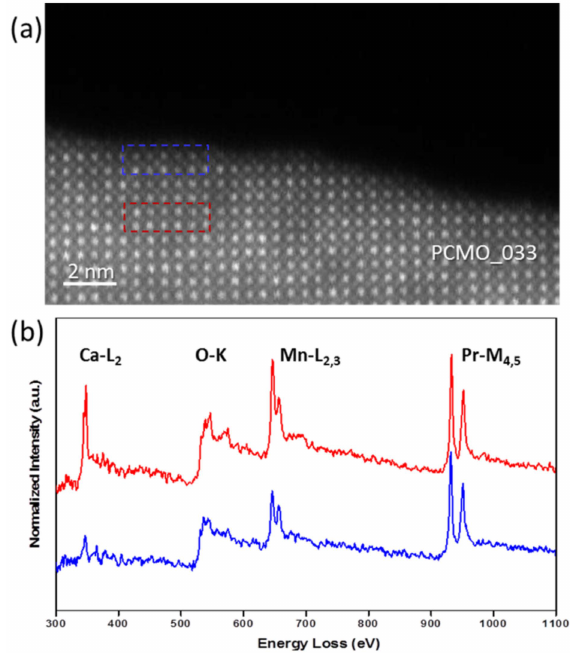
Figure 5. ( a ) HRSTEM image of PCMO (x = 0.33) with two selected area used to verify the chemical composition of original PCMO material and recrystallized amorphous layer. The corresponding normalized spectra (1 eV / channel) are shown in ( b ), and the signal from Ca is remarkably weaker at the Catalysts 2019 , 9 , x FOR PEER REVIEW last unit cell.